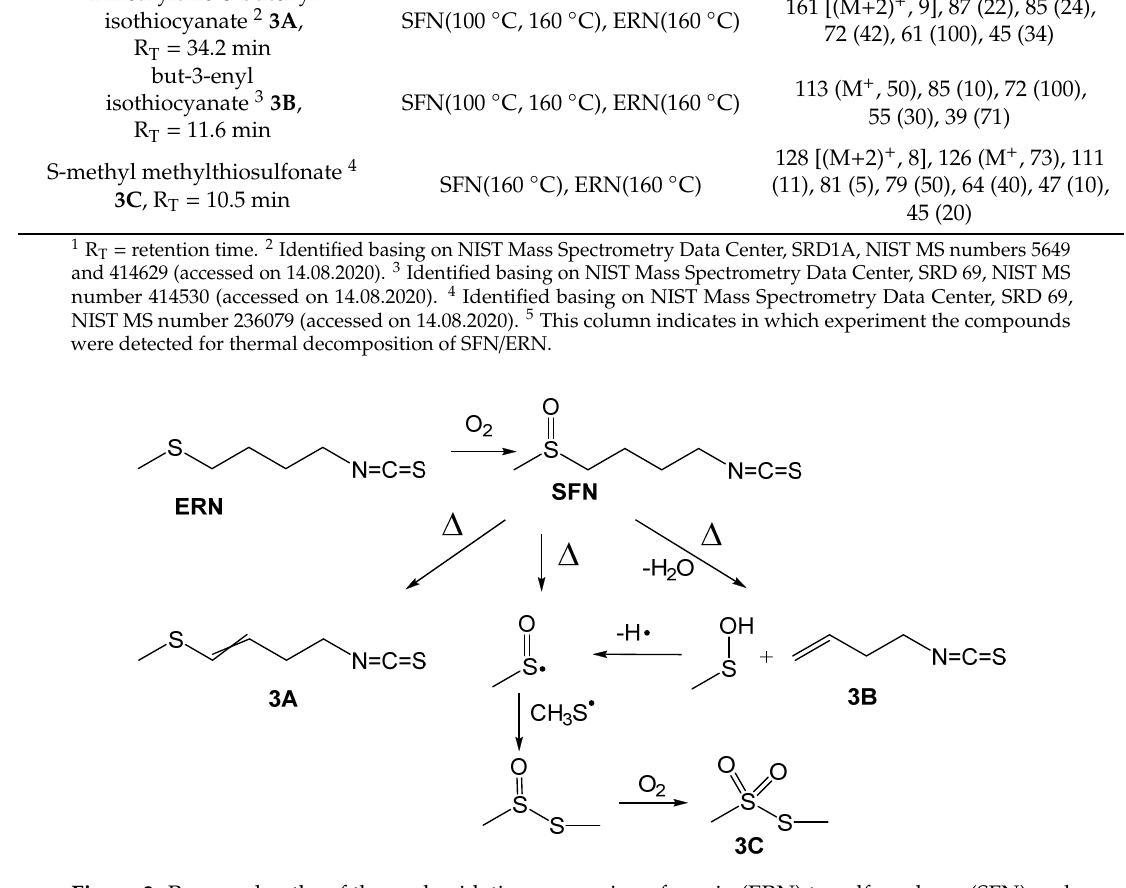
Figure 3. Proposed paths of thermal oxidative conversion of erucin (ERN) to sulforaphane (SFN) and subsequent decomposition to the products detected by GC/MS and showed in Table 1.